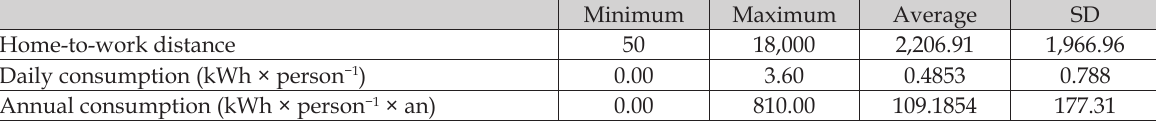
Table 4. Descriptive statistics of the energy consumption generated by commuting to